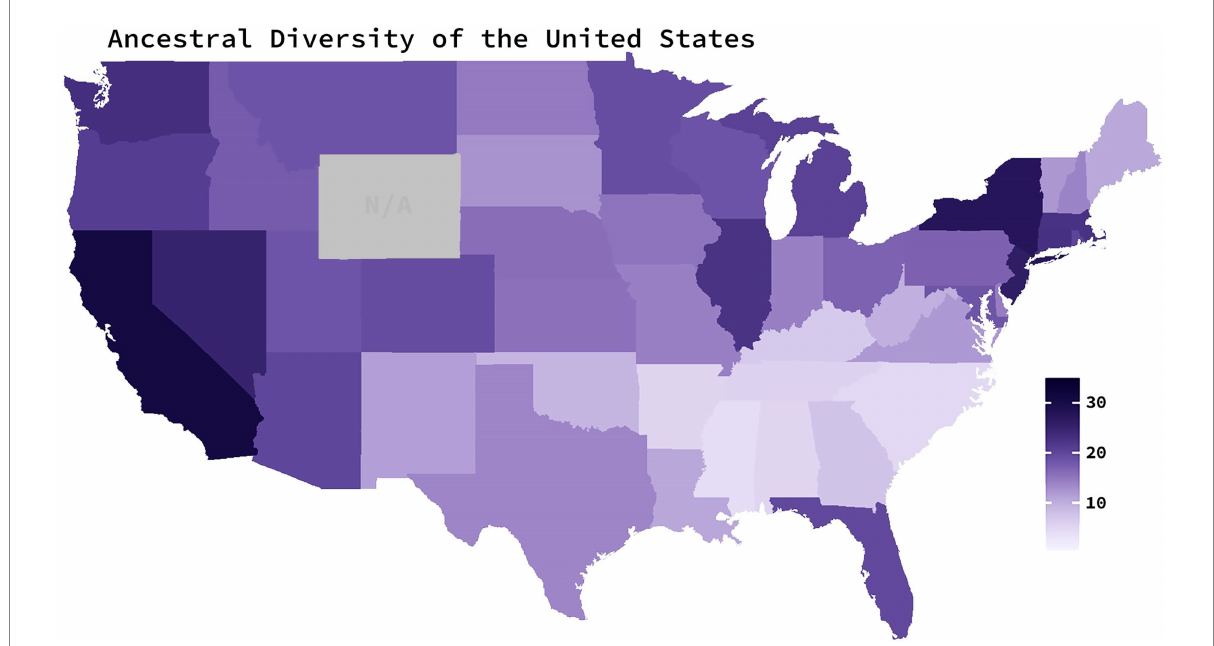
FIGURE 1 Ancestral diversity of the United States. Average number of foreign countries which have contributed to at least 0.5% of a state’s population since 1850. Darker colors indicate a larger number of source countries (operationalized as high ancestral diversity). Scores are based on decennial census data from 1850 to 2010. Gray indicates missing